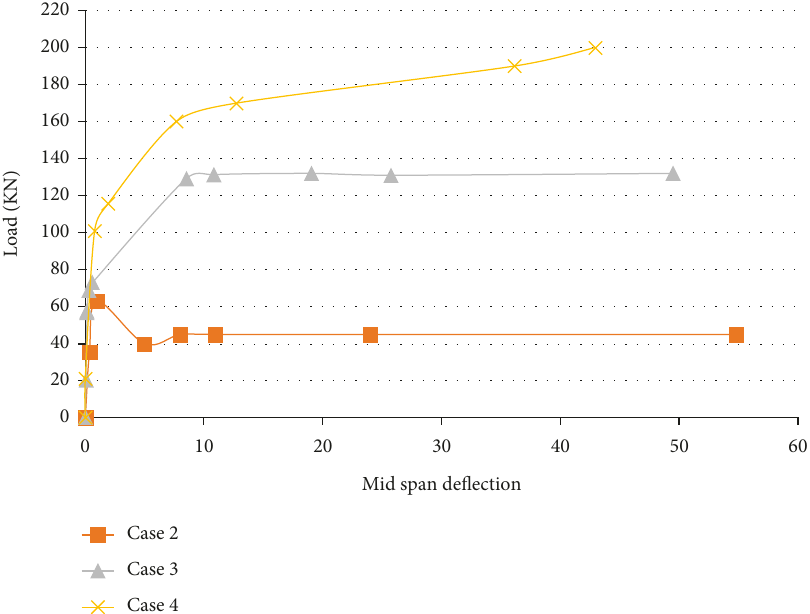
Figure 14: Load-deflection graph types according to the reinforcement ratio.